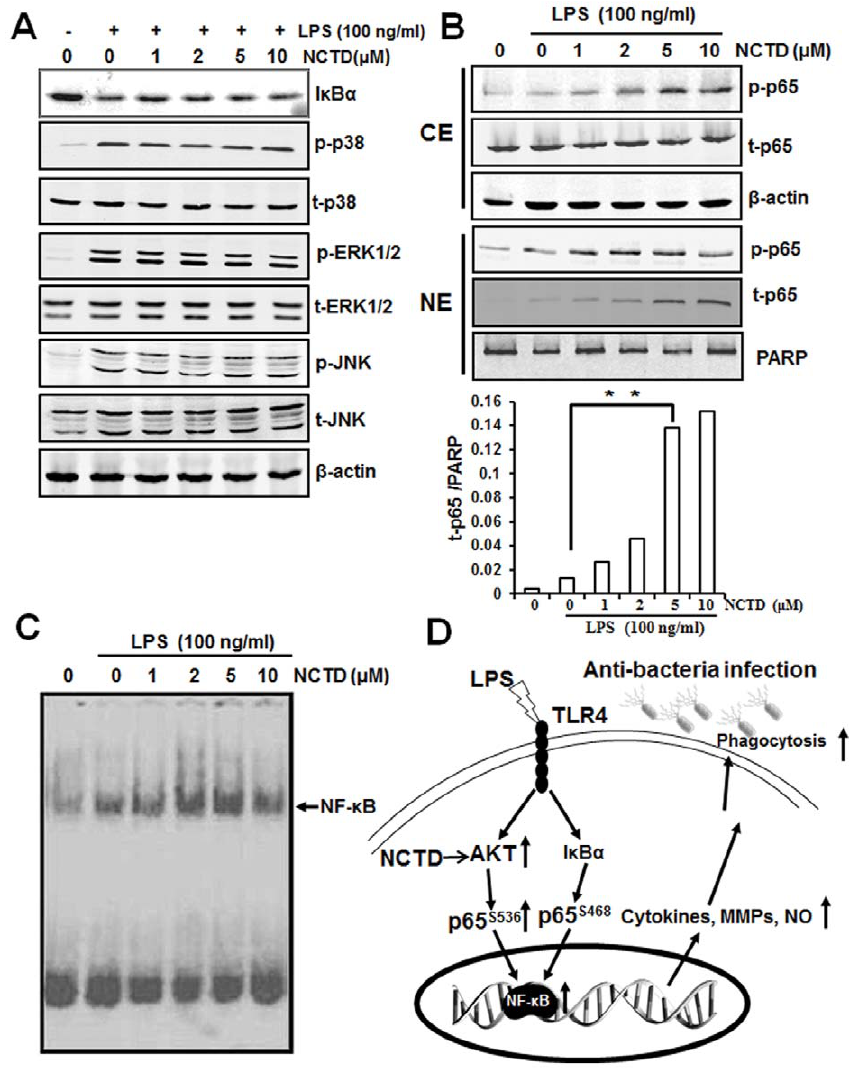
Figure 7. Regulation of NCTD on LPS induced NF- k B activation. A. Little influence was observed by NCTD on I k B a and MAPK signaling pathway. RAW264.7 cells were treated with PBS (containing 0.1% DMSO) or 1–10 m M NCTD for 24 h and then stimulated with 100 ng/ml LPS for different time. The protein levels of I k B a and MAPK signaling pathway in RAW264.7 cells were determined using western blotting. B. The translocation of p65 to nucleus was increased in NCTD treated macrophages. Cells (2 6 10 6 cells/ml) were incubated with PBS (containing 0.1% DMSO) or 1–10 m M NCTD for 24 h and treated with 100 ng/ml LPS for 15 min. Cytoplasmic extracts (CE) and nuclear extract (NE) were prepared and analyzed by western blot analysis using specific antibodies. And the translocation of p65 to nuclear was also quantitatively analyzed. C. LPS induced DNA binding ability of NF- k B was enhanced by NCTD in a dose dependent manner. Cells were treated with PBS (containing 0.1% DMSO) or 1–10 m M NCTD at 37 u C for 24 h and then activated with 100 ng/ml LPS for 30 min. Finally, nuclear extracts were prepared and then assayed for NF- k B activation by EMSA as described under Materials and Methods. Three independent experiments were performed. D, Diagram of NCTD facilitates LPS-mediated immune responses by up-regulation of AKT/NF- k B associated signaling